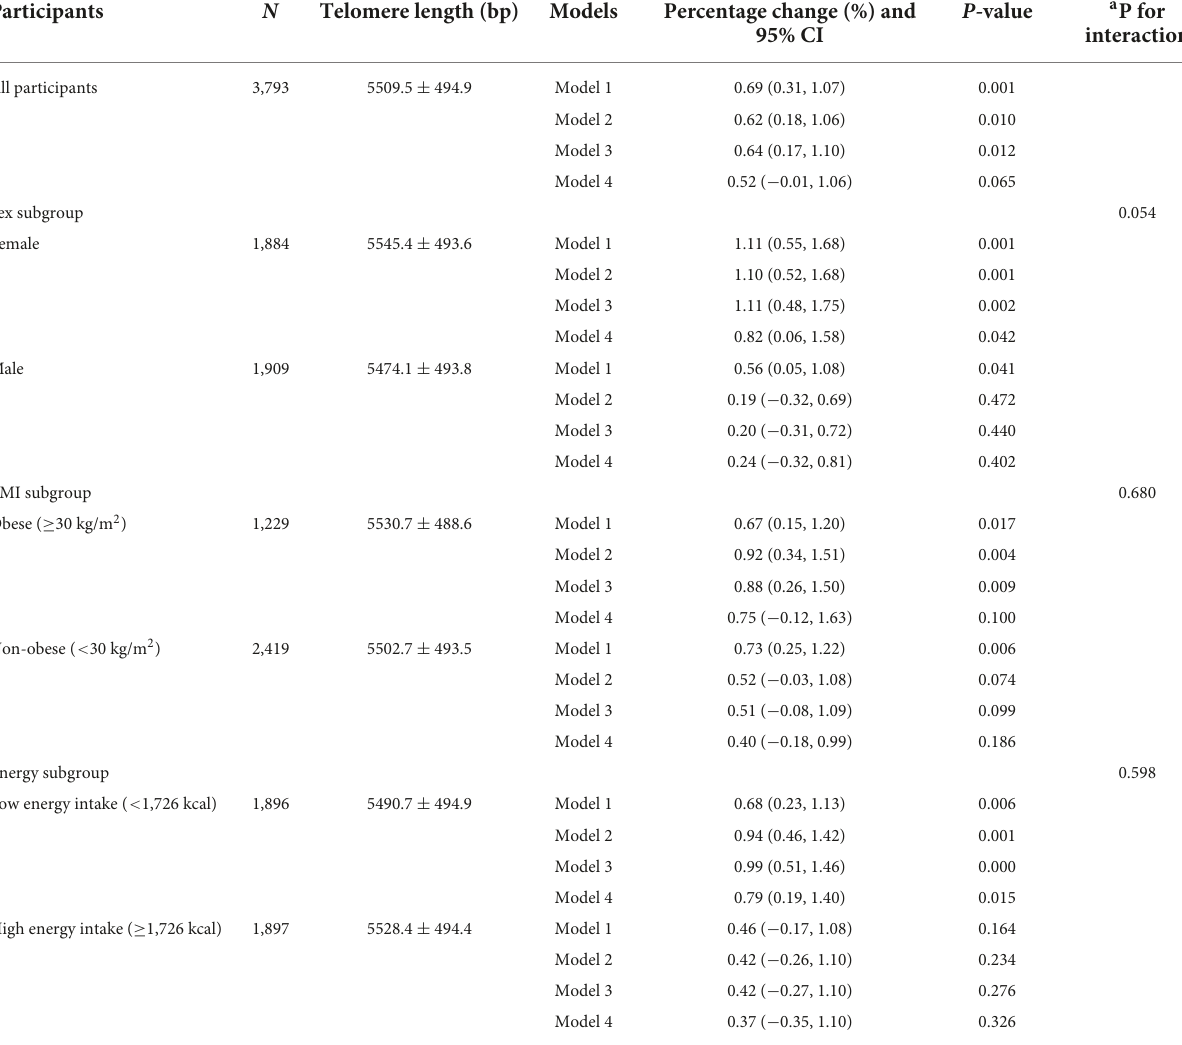
TABLE 2 The association between dietary zinc intake and telomere length among all participants and subgroups.